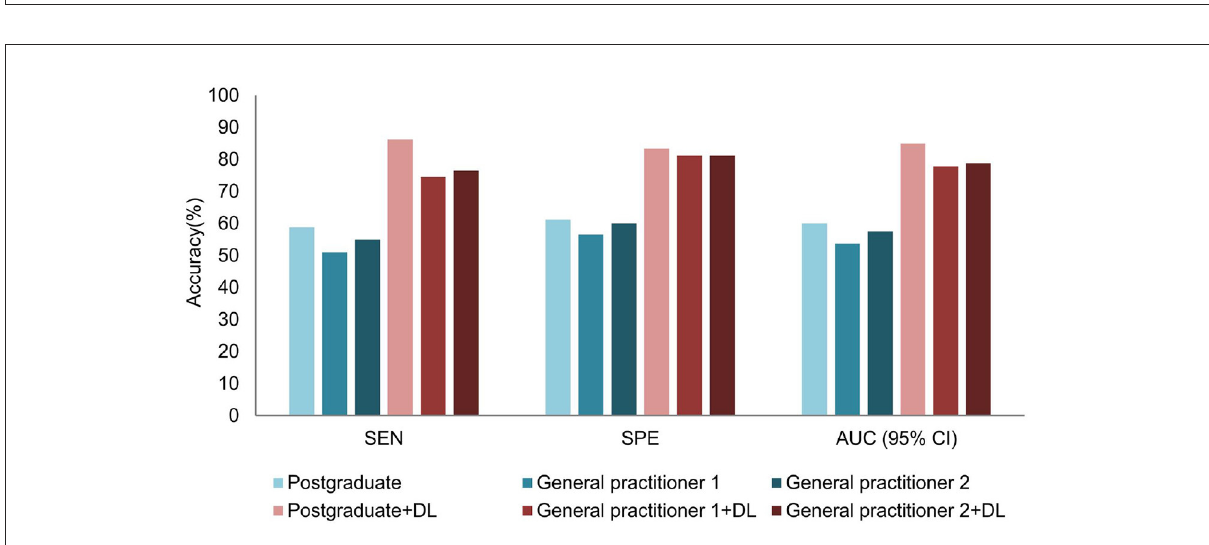
FIGURE6 Comparison before and after DL model assistance for graduate students and general practitioners in the test